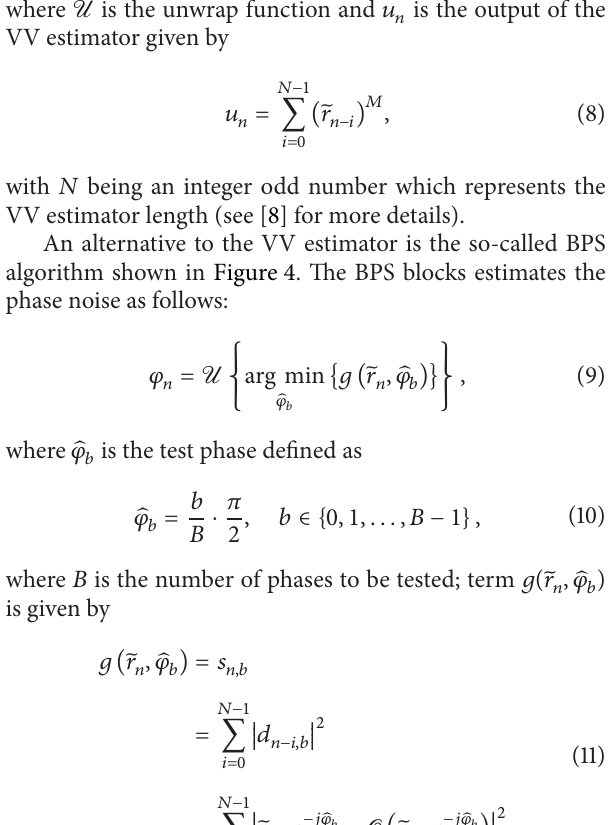
Figure 3: Block diagram of the Viterbi-Viterbi algorithm.